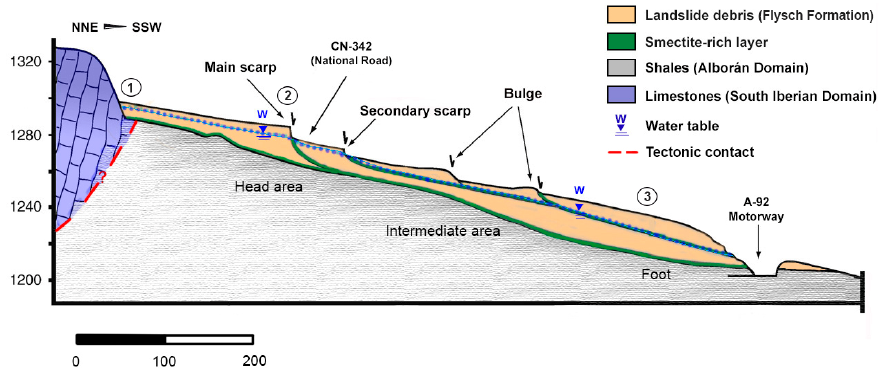
Figure 2. Geological cross-section of the Diezma landslide along the NE-SW direction. Vertical and horizontal scales are in meters (modified from [11]). The points indicated correspond to those of the water sampling.